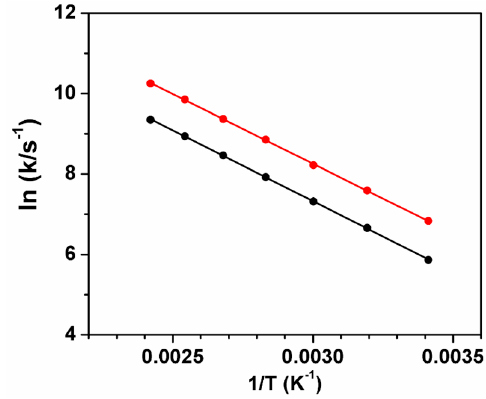
Figure 6. Arrhenius plot for 12 C 70 (black dots) and 13 C 70 (red dots) in DHOC4.